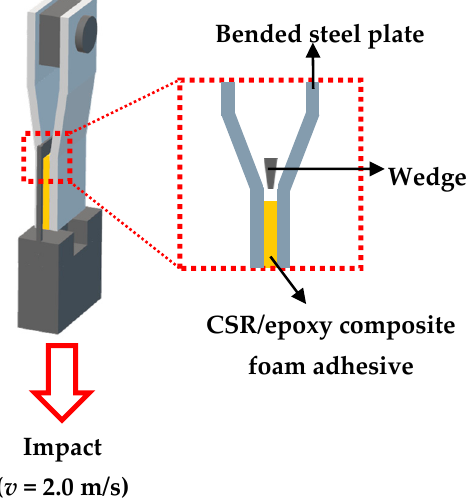
Figure 2. Schematic illustration of specimen prepared for impact wedge–peel test.